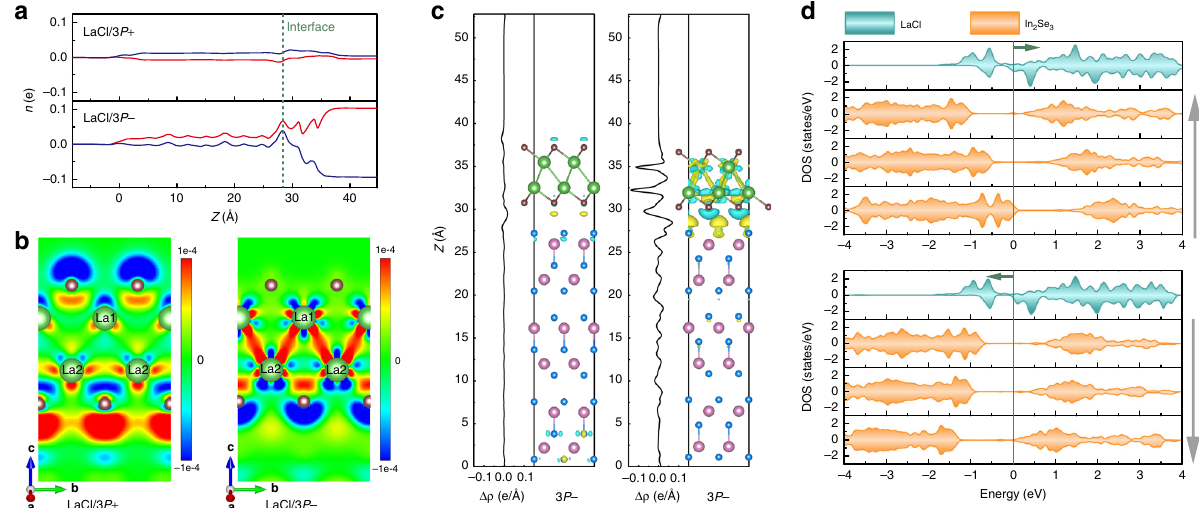
Fig. 5 Charge transfer in different polarization states. a Spin-up (red line) and -down (blue line) contributions on the charge transfers in LaCl/3 P ± HSs. b Differential charge density on the LaCl side. c Differential charge density distributions of LaCl/3 P ± HSs and integrals of differential charge densities (black line). d The layer-resolved partial DOS of LaCl/3 P ± HSs. The gray and green arrows represent the polarization direction of In 2 Se 3 and the moving direction of Fermi level in HSs,